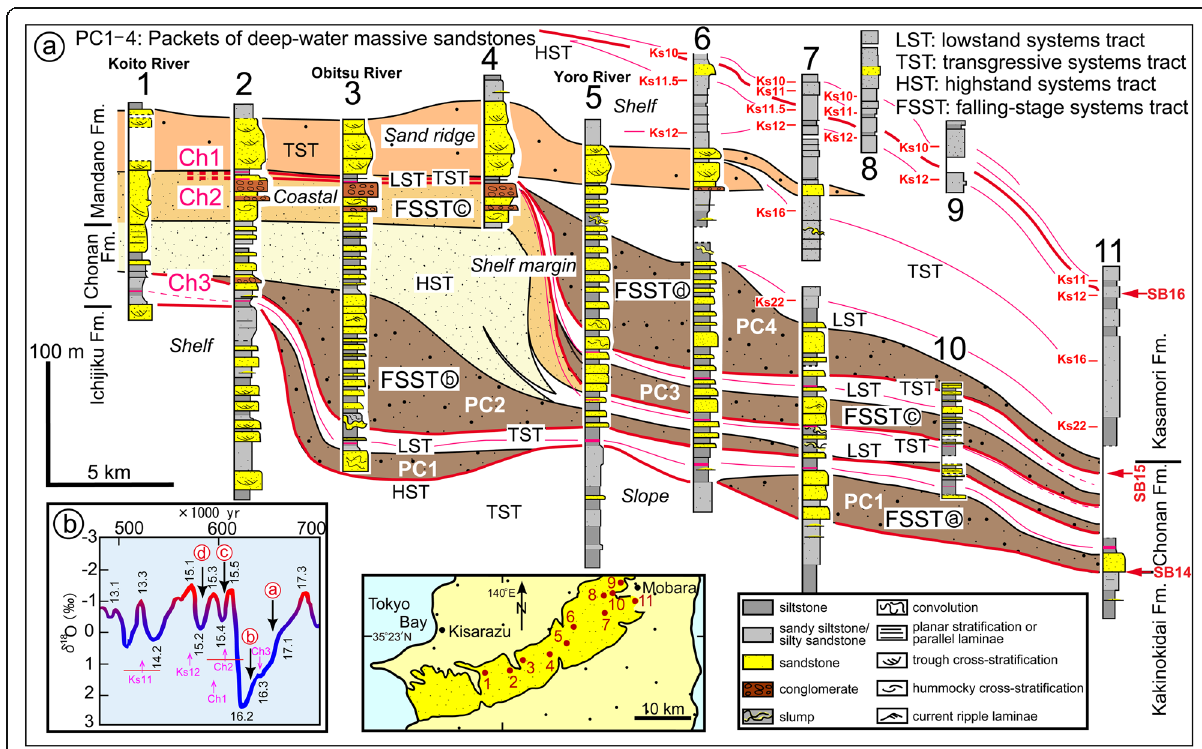
Fig. 5 a Stratigraphic cross-section of the Chonan and Mandano formations. Modified from Ito (1992) and Ito et al. (2006a). SB14 – SB16 are sequence boundaries defined by Ito and Katsura (1992). See Fig. S1 for the stratigraphic positions of SB14 – SB16 within the Kazusa Group. The coding of tephra key beds , such as Ch1 – Ch3 and Ks22 – Ks10, is given on the left side of sections. Thin red lines indicate the correlation of the tephra key beds, and those with single arrows show onlap or toplap terminations of time lines. Solid red lines indicate sequence boundaries. b Tentative correlation of the timing of falling-stage deposition (a – d in a ) and some tephra key beds with the oxygen isotopic sea-level index of Bassinot et al. (1994). Thin red horizontal lines in Ch2 and Ks11 indicate error bars for the numerical ages of these tephra key beds described in the text. The inset map shows the locations of the measured